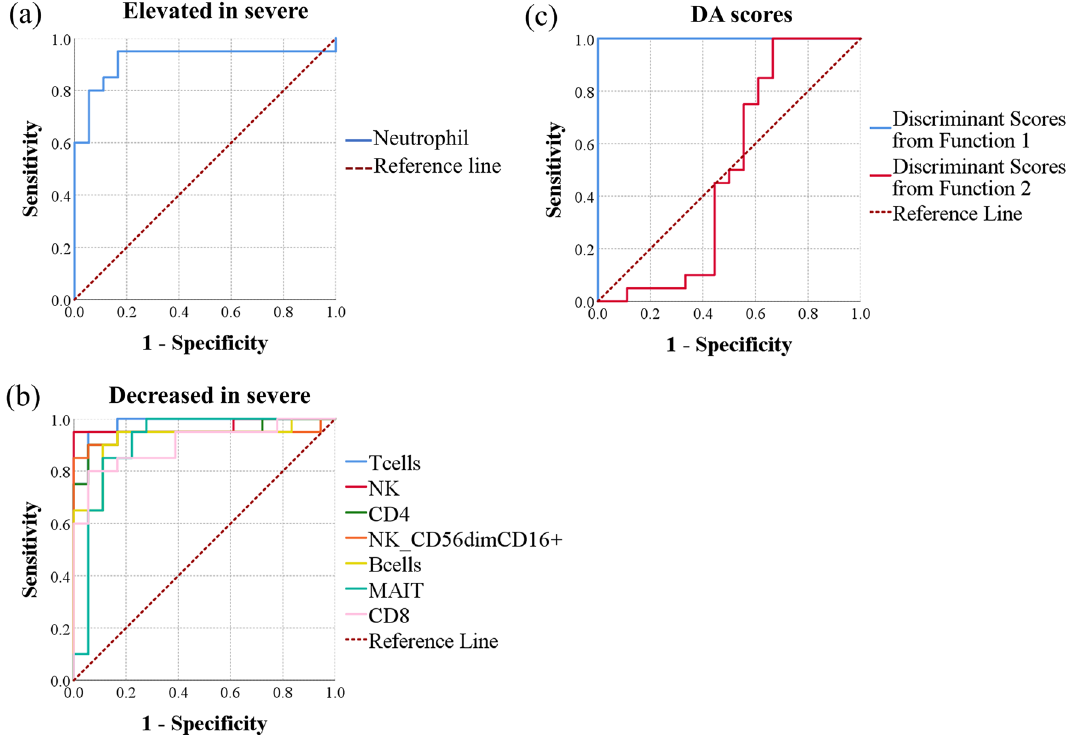
Figure 5. Evaluation of the ability of individual biomarkers and discriminant analysis-based multivariate biomarkers to predict severe COVID-19 disease in a population of healthy donors and COVID-19 patients. ROC curves were generated using data from healthy control participants (n = 12), patients with moderate disease (n = 7), and patients with severe disease (n = 27). ROC curves of ( a ) individual analytes elevated in severe COVID-19, ( b ) individual analytes decreased in severe COVID-19, ( c ) discriminant scores from functions 1 and